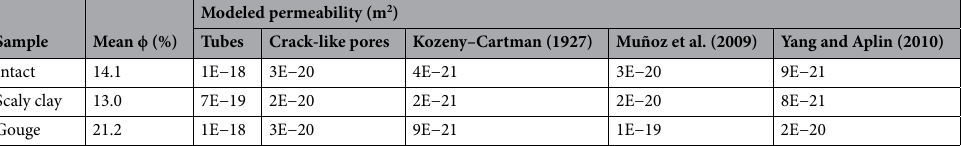
Table 4. Mean experimental porosity (%) and modeled permeability (m 2 ) of intact, scaly clay, and fault gouge samples. Mean values correspond to the average of all experimental data for each